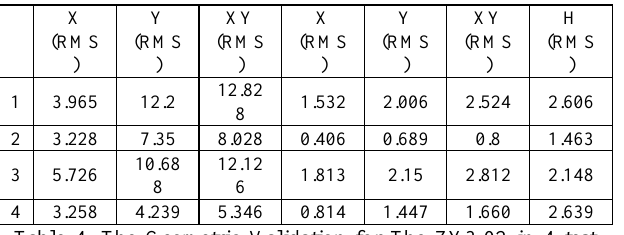
Table 4. The Geometric Validation for The ZY3-02 in 4 test